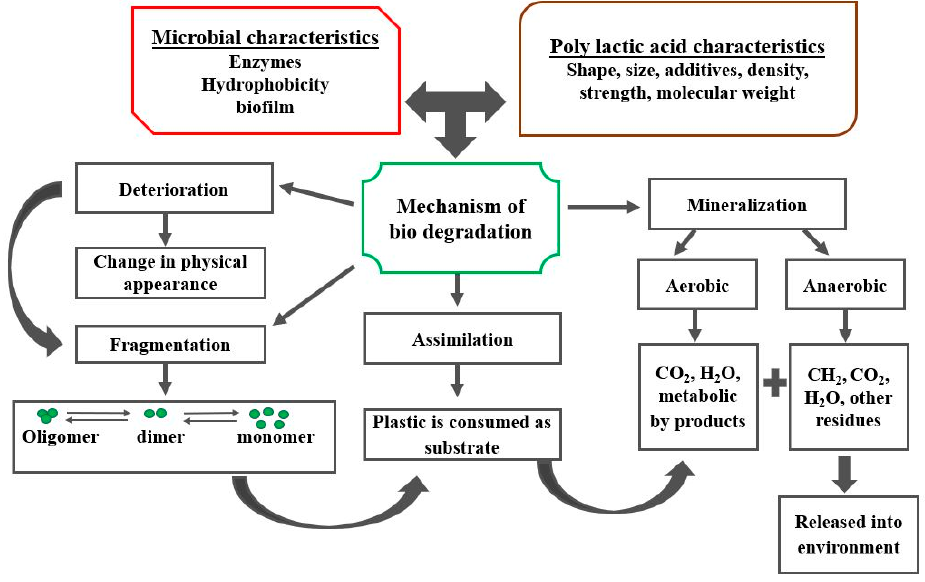
Figure 4. Biodegradation mechanism of PLA.